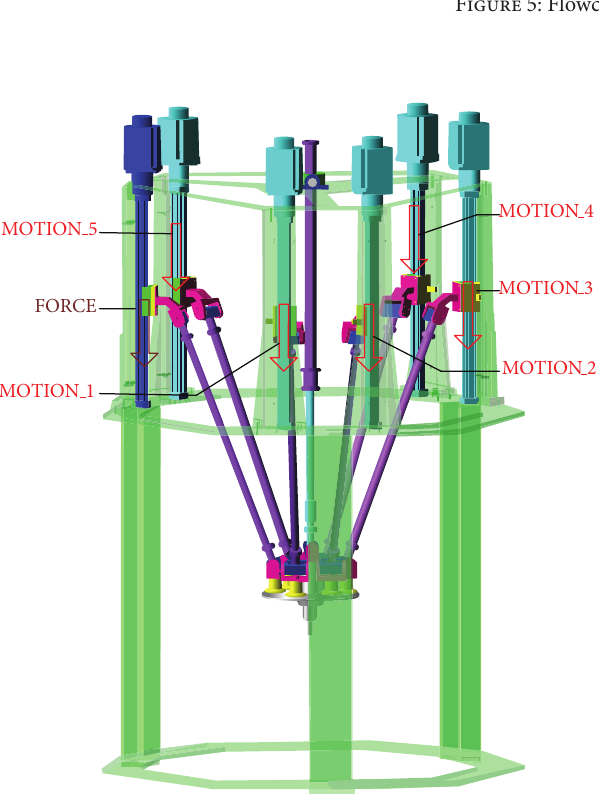
Figure 6: 3D model in Adams.